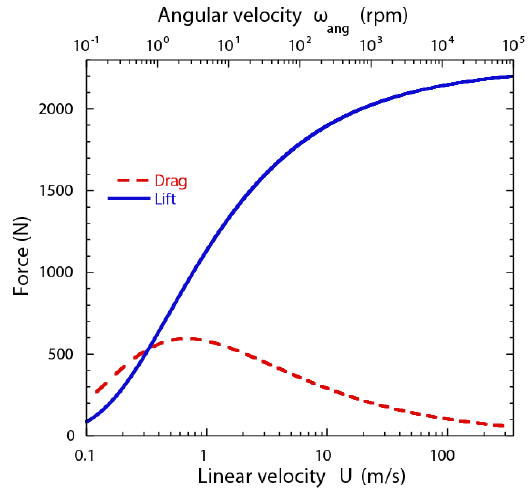
Figure 9. Lift and drag force versus axial speed for a maglev system traveling over an aluminum track at a fixed displacement gap of 10 mm. Bottom abscissa: Linear velocity U of passive maglev; Top abscissa: Angular velocity ω ang of active maglev.